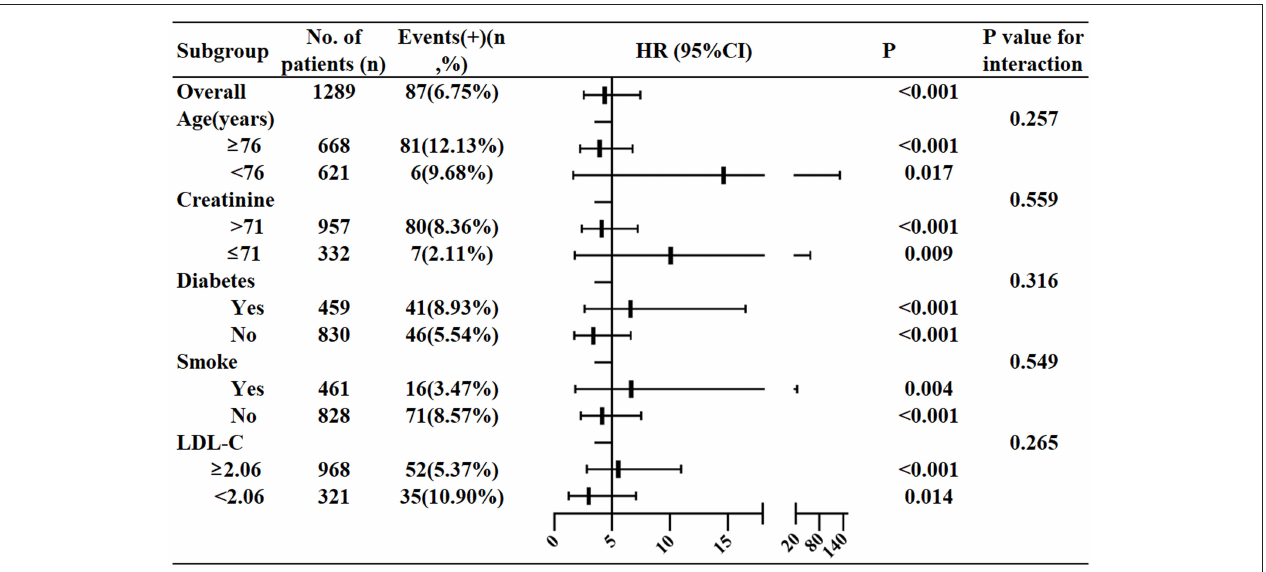
FIGURE 2 | Hazard ratios of the NLR for predicting in-hospital death in NSTEMI group in the subgroup analysis.